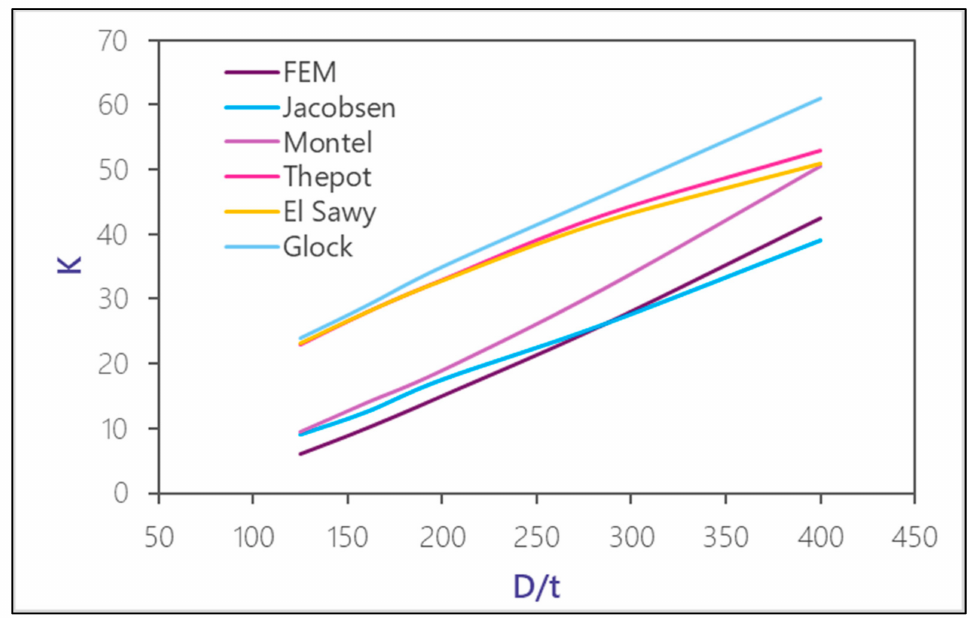
Figure 12. Factor K obtained through analytical approaches, compared with FEM results, for a liner with radial constraint and g / R = 0.0015 and g = 0.6 mm.